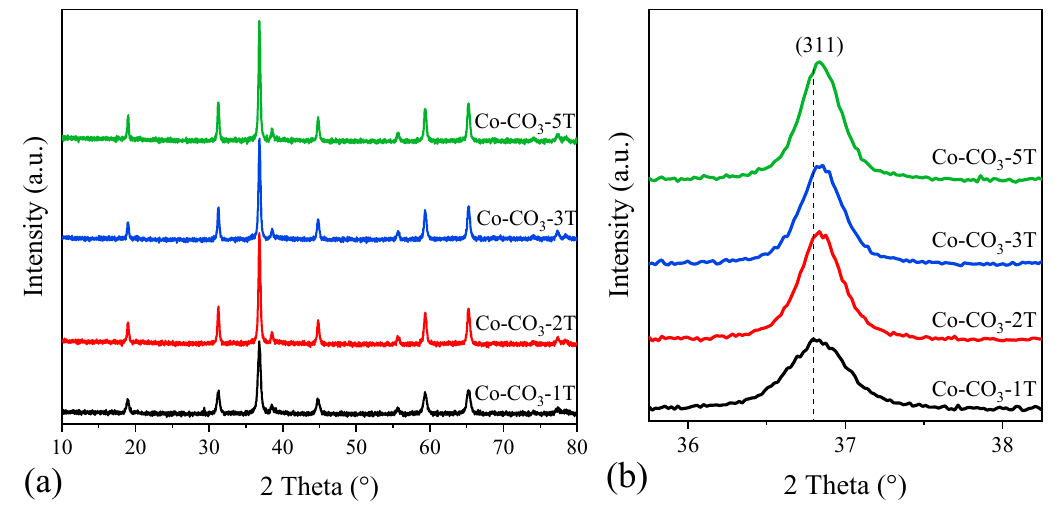
Figure 2. ( a ) XRD patterns of the catalysts; ( b ) enlargement of the most intense diffraction peak (311).